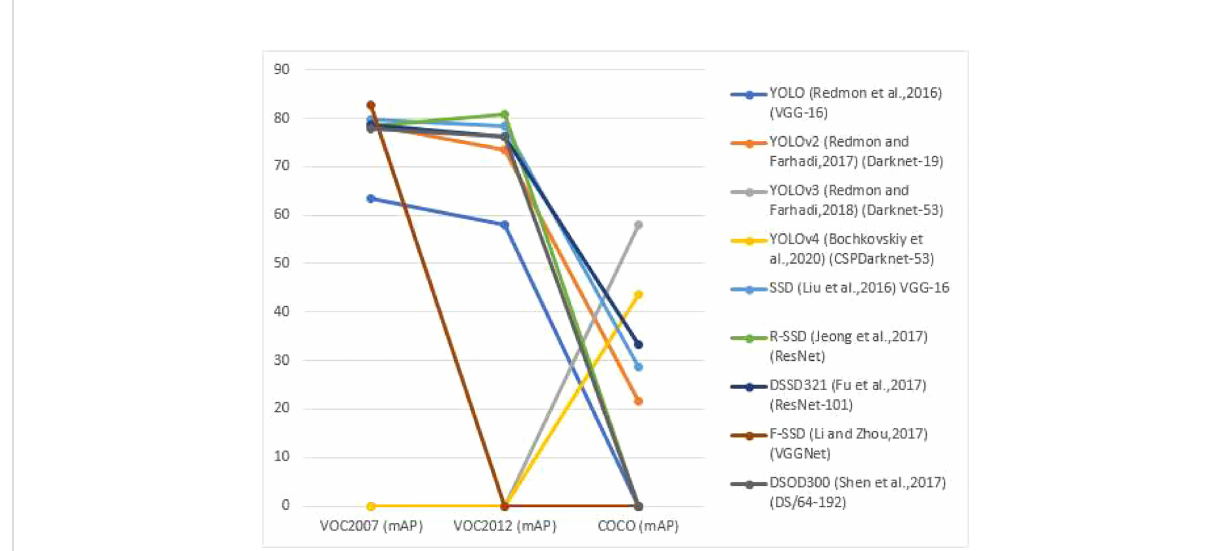
FIGURE 3 Performance assessment of single-stage Object detection algorithms in different